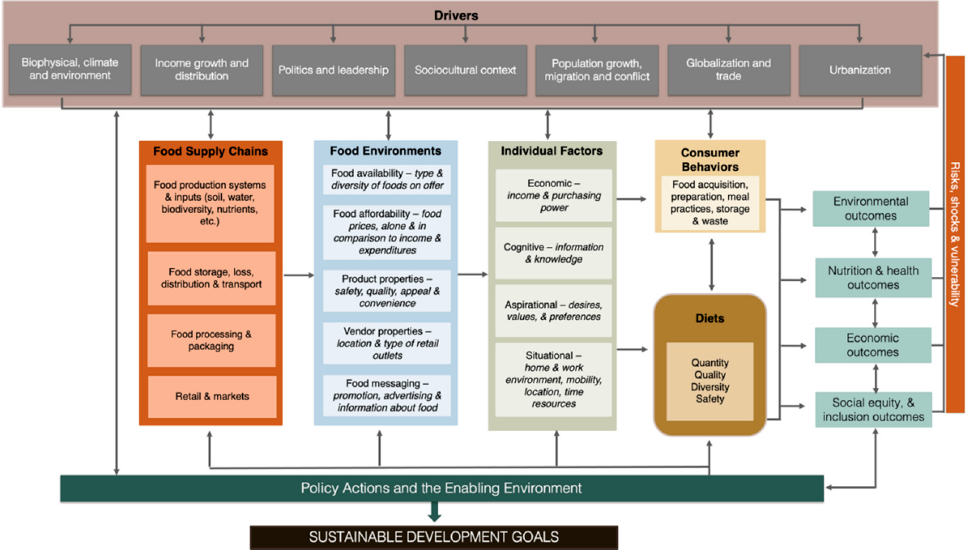
Figure 1. A food systems framework. Source: [48].